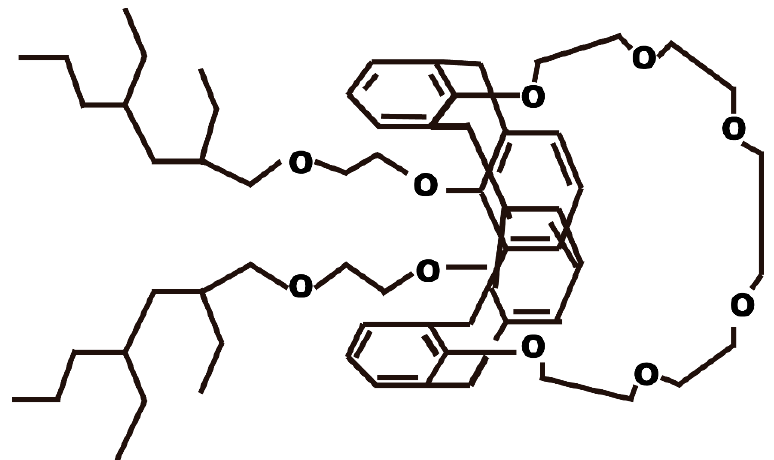
Figure 8. The chemical structural formula of Calix {4} arene-R14 [56].